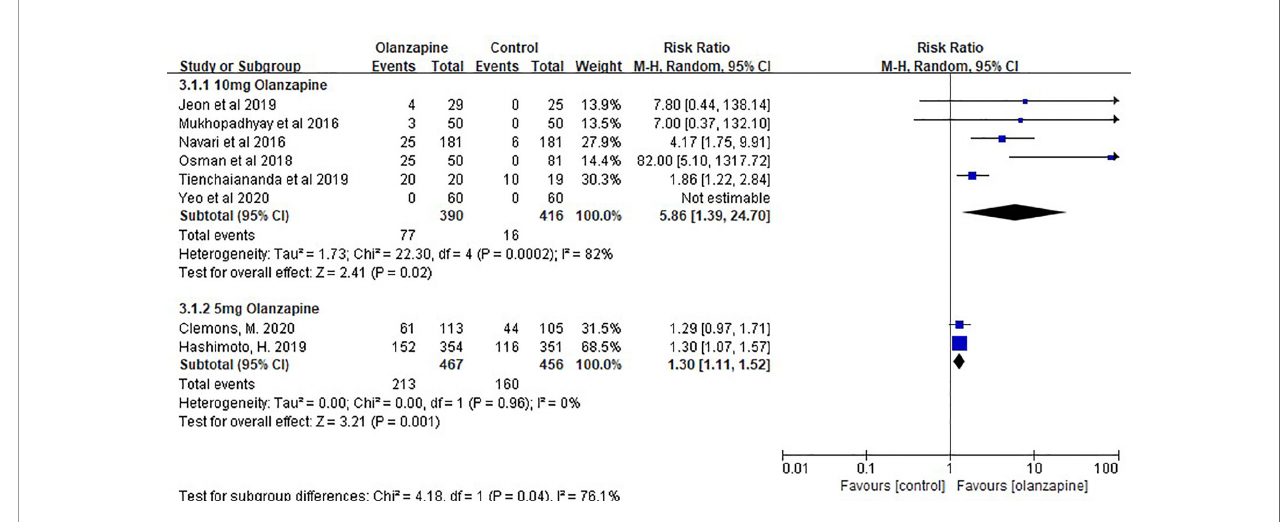
FIGURE 3 | The somnolence effect of Olz(10mg and